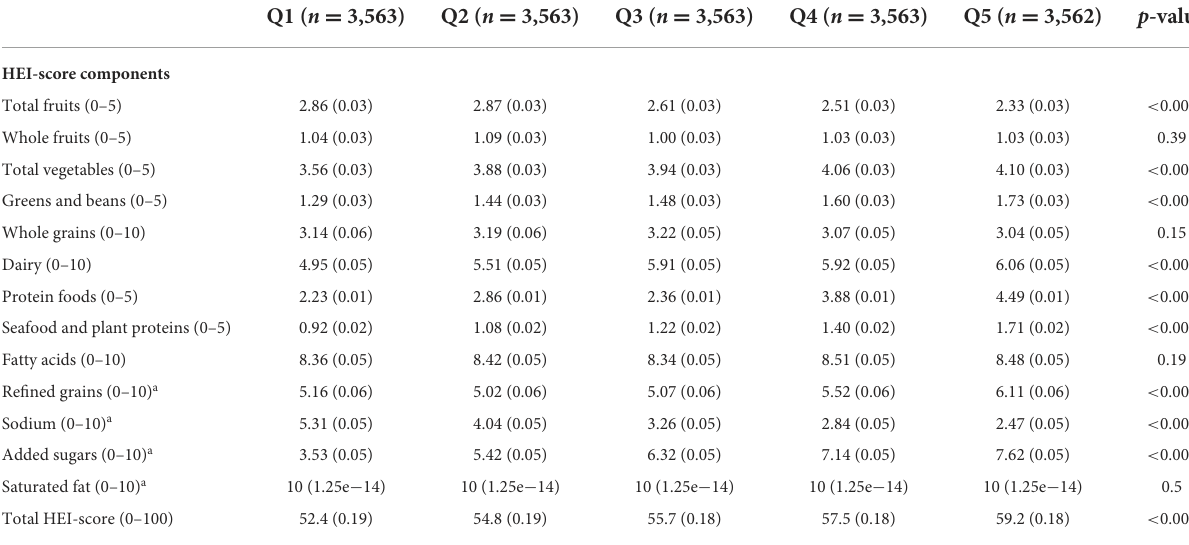
TABLE 2 Differences in Healthy Eating Index 2015 scores across %E P:C z -score quintiles.